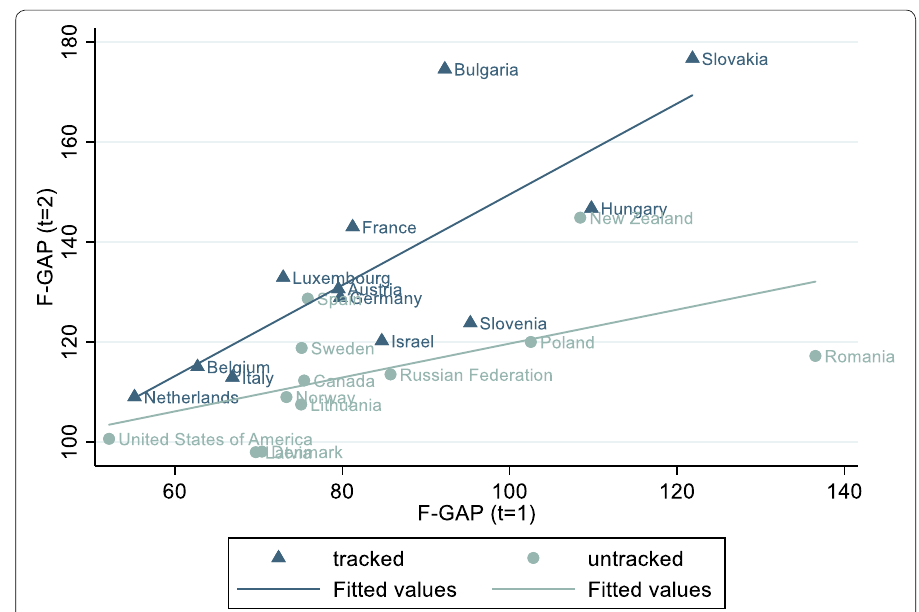
Fig. 1 Family background effects at t